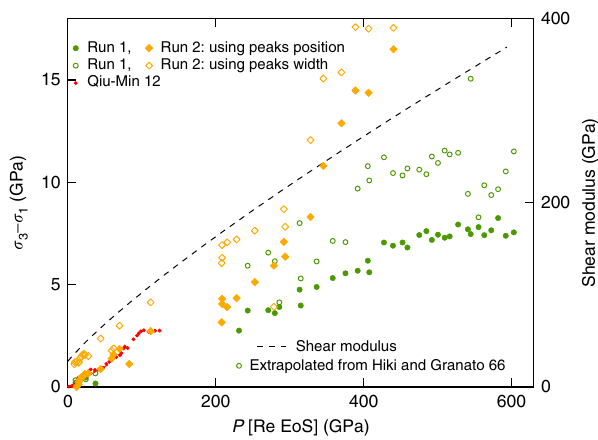
Fig. 4 Uniaxial stress sustained by gold samples. The uniaxial stress is estimated using two methods: 37,41 comparison between the position of (111) and (200) gold XRD lines (closed symbols), and width of (111) and (200) gold XRD lines (open symbols). The averaged shear modulus of gold 42 is represented as a dashed line for comparison. Recent measurements of gold yield strength up to 127 GPa are also plotted (red dots)